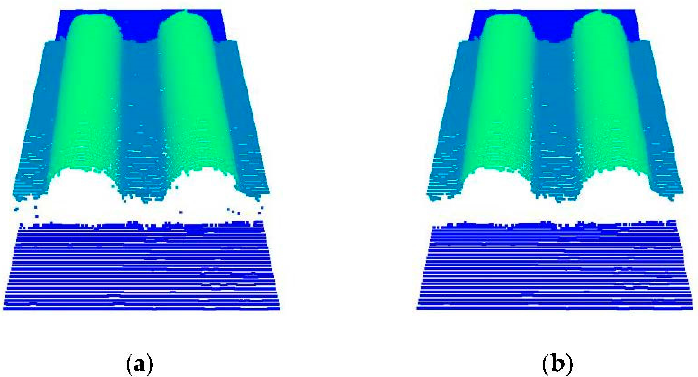
Figure 3. Point cloud before and after statistical filtering: ( a ) raw point cloud and ( b ) point cloud after statistical filtering.